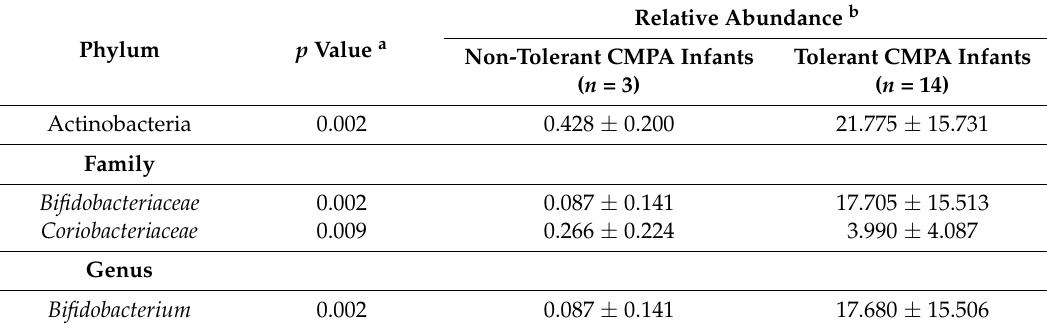
Table 1. Significant differences (at different taxonomic ranks) in fecal microbial abundances (%) between tolerant and non-tolerant infants with non-IgE mediated cow’s milk protein allergy (NIM-CMPA) after a period with a diet free of cow’s milk protein (CMP).